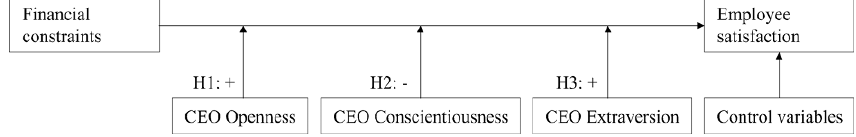
Fig. 1 Overview of research